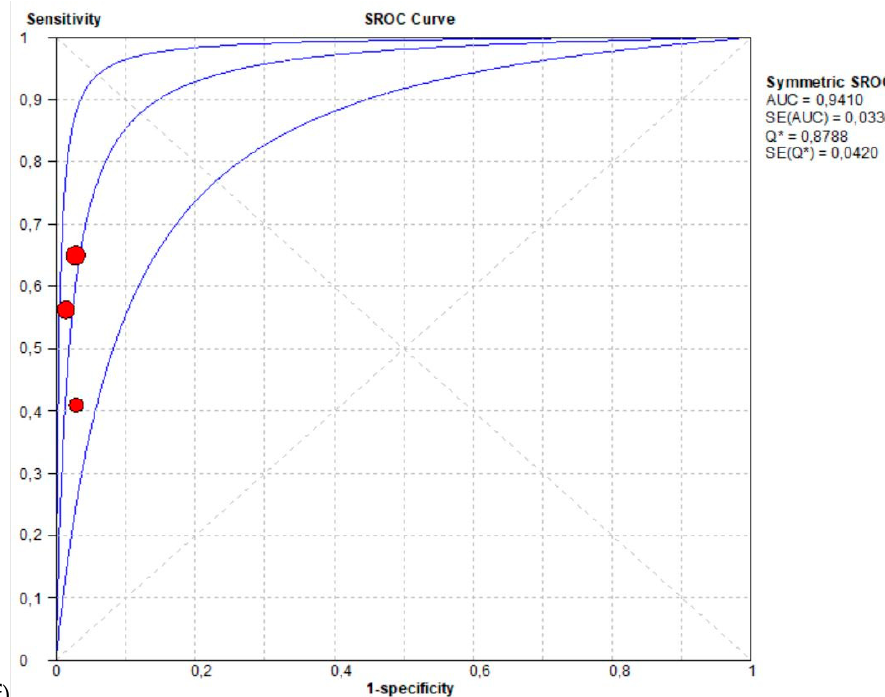
Figure 3. ( a , b ) Forest plot of 18F-Fluciclovine PET/CT for preoperative LN staging (sensibility and specificity). ( c , d ) Forest plot of 18F-Fluciclovine PET/CT for preoperative LN staging (positive and negative likelihood ratio). ( e , f ) Pooled DOR and SROC curve of 18F-luciclovine PET/CT for preoperative LN staging.